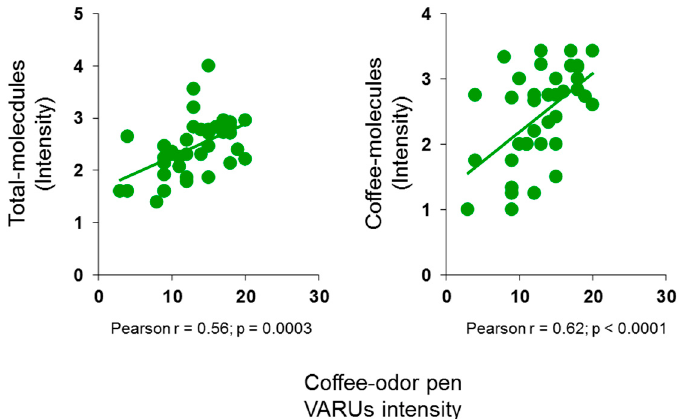
intensity perceived for the coffee-odor pen by each subject.